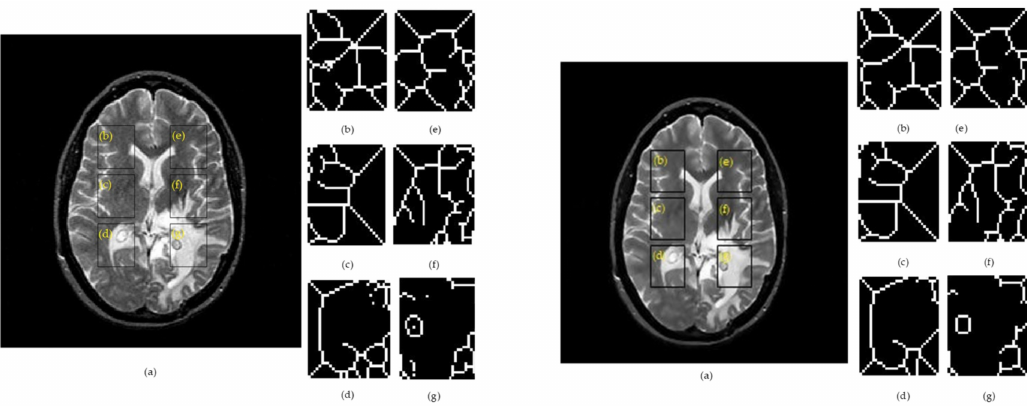
Figure 3. Results of the skeleton algorithm for a T2w image belonging to a patient with glioma, where: Left side: ( a ) raw image. Right side: ( a ) denoised image. ( b ) ROI 1L; ( c ) ROI 2L; ( d ) ROI 3L; ( e ) ROI 1R; ( f ) ROI 2R; and ( g ) ROI